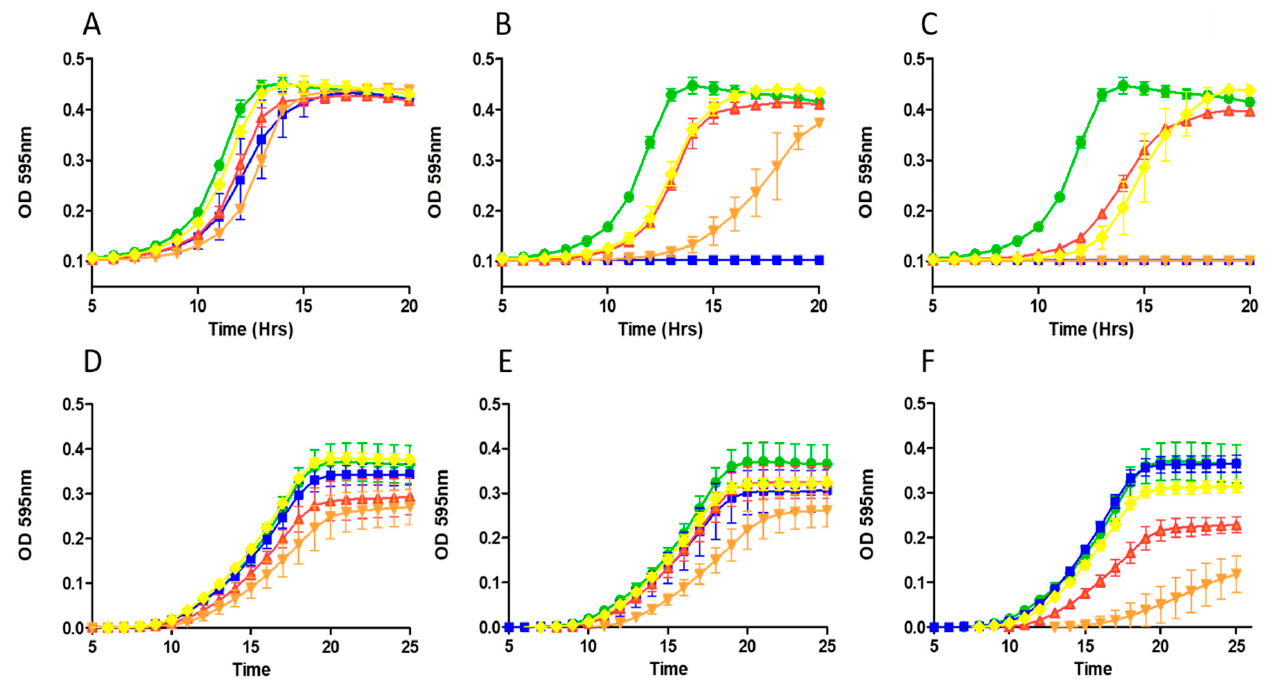
Figure 3. Impact of increasing concentrations of nisin A and nisin derivatives on growth of lactococci. Effect of nisin A (blue square) and nisin variants nisin A M17Q (orange triangle), nisin A HTK (red triangle) and nisin A T2L (yellow diamond) and untreated control (green circle) on L. lactis KH in 0.14 µ g/mL ( A ), 0.32 µ g/mL ( B ) and 0.64 µ g/mL ( C ) and L. lactis IP5 in 0.16 µ g/mL ( D ), 0.32 µ g/mL ( E ) and 0.48 µ g/mL ( F ). The means and standard deviations of three independent determinations are presented.